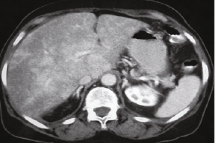
Figure 2: Case 5. Axial postcontrast CT scan showed patchy heterogeneous enhancement of liver